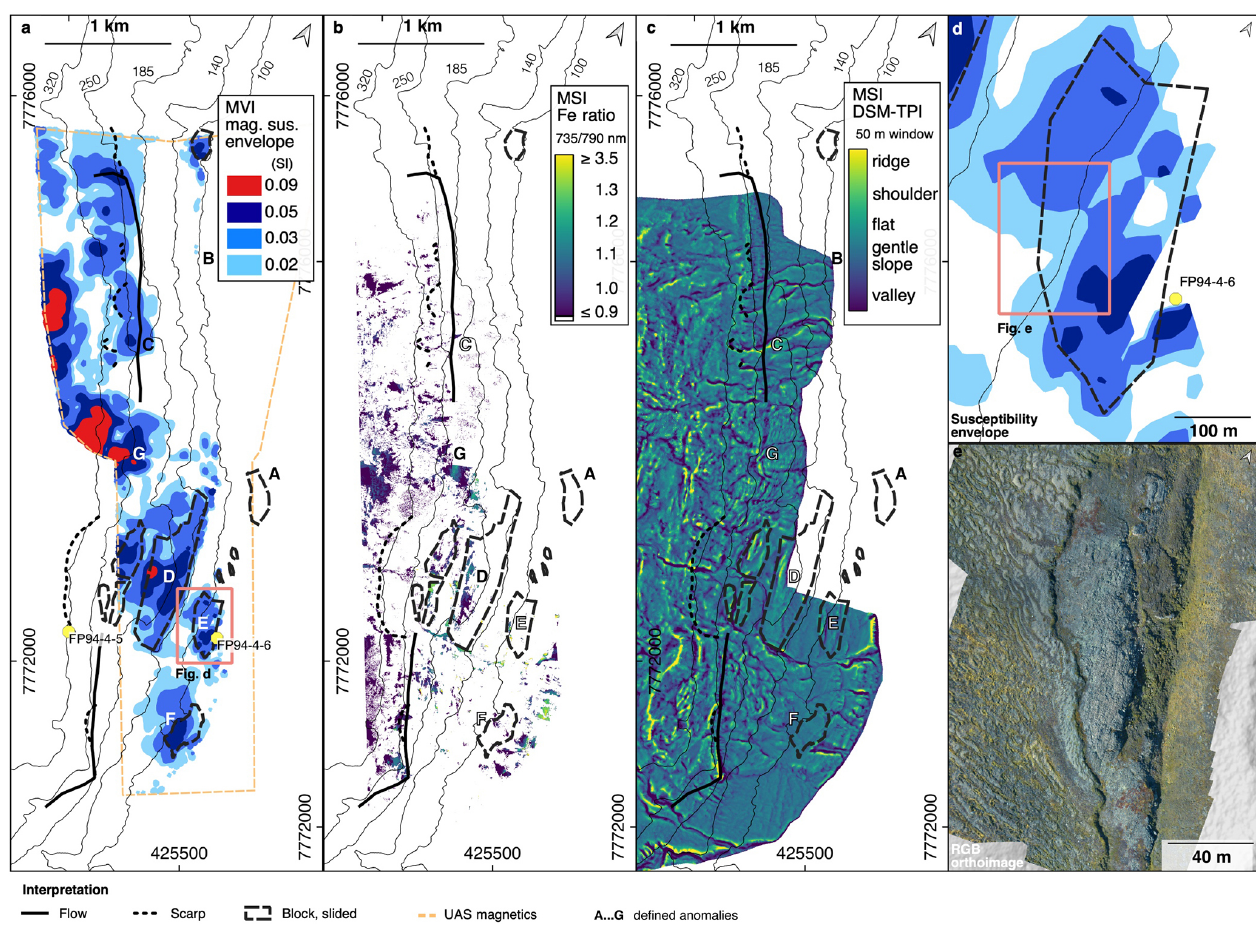
Figure 12. Integration of UAS-based data. (a) Isosurfaces of magnetization amplitudes obtained from the constrained MVI inversion. (b) Iron band ratio from multispectral UAS mosaics showing abundance of iron-rich alteration products on the surface. (c) Photogrammetry-based TPI calculated from pixels in a 50m × 50m moving window shows graduation from incised valleys, to flat slopes, to ridges. (d) Isosurfaces of magnetization amplitudes from the MVI model. (e) RGB orthomosaic from a single RGB reconnaissance flight (DJI Mavic). The letters A to G refer to the magnetic anomalies defined in Fig.